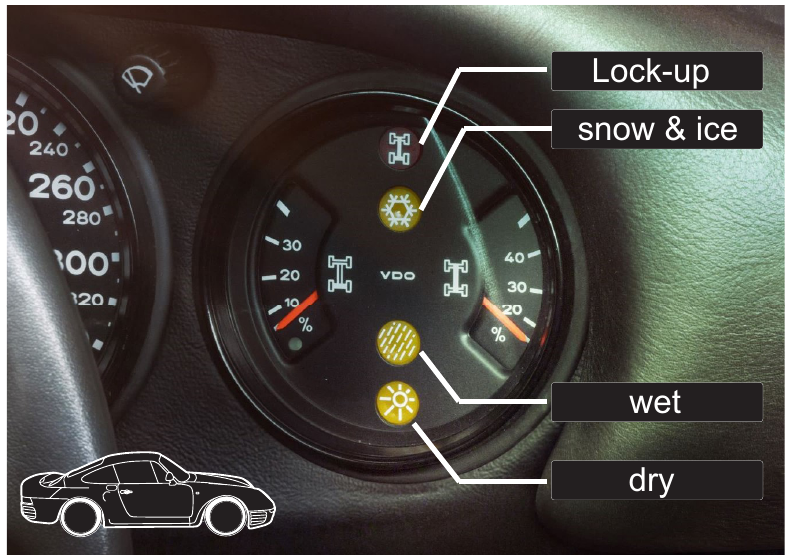
Figure 1. Driving mode selection in the Porsche 959 (1986–1988). Operated manually by the driver. [Source: Porsche